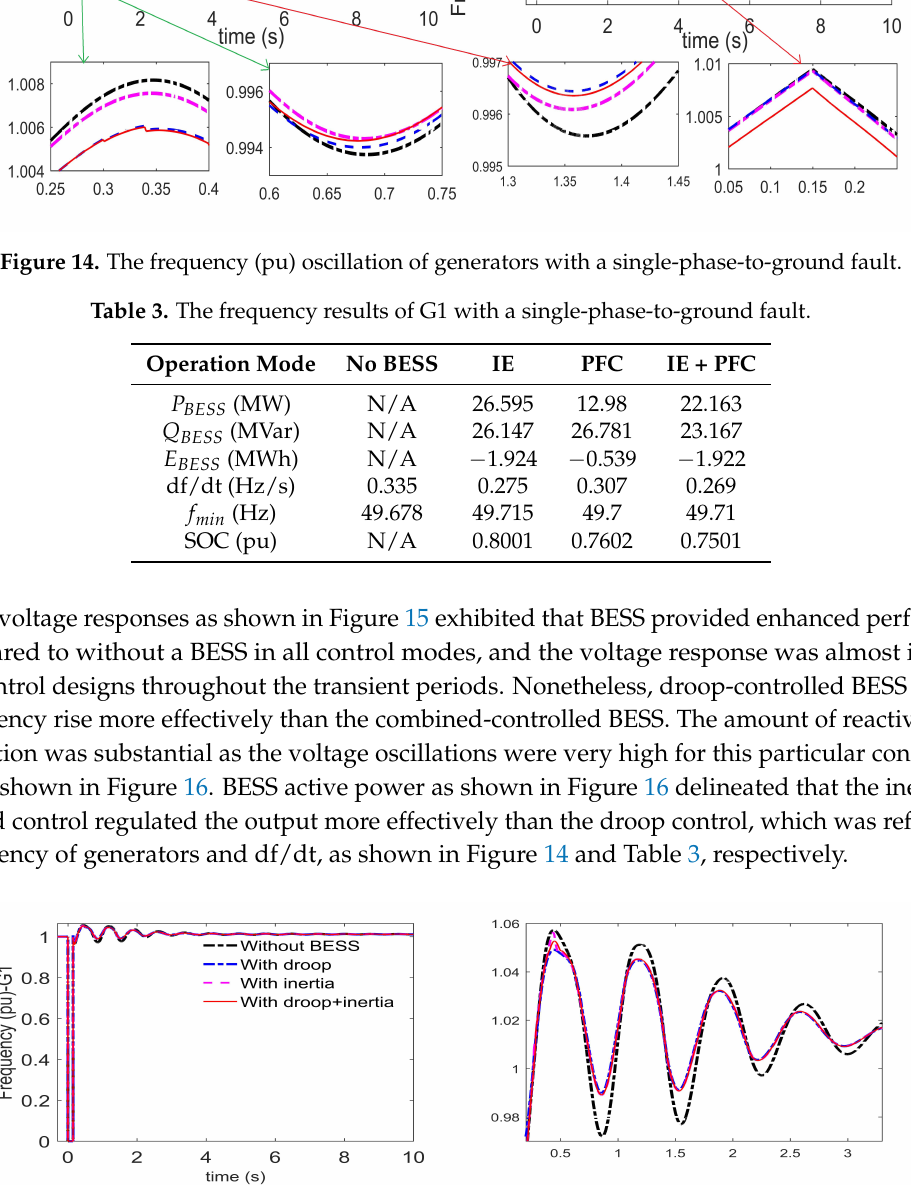
Figure 15. The voltage (pu) oscillation of generators with a single-phase-to-ground